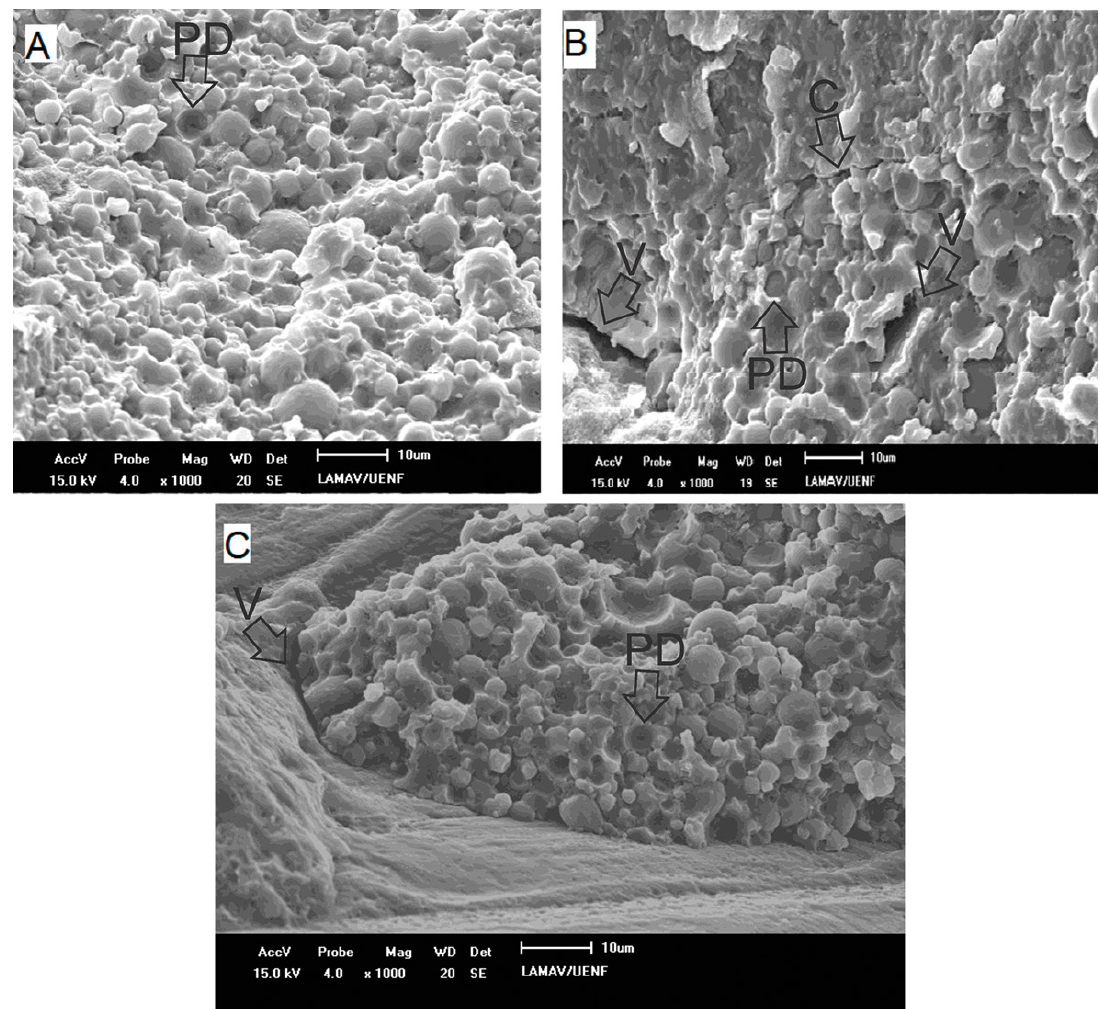
Figure 4: Sample surface micrographs with magnification of 1000x for formulations: A) P(3HB):ND(8:1), B) P(3HB):ND(12:1) and C) P(3HB):ND(16:1). The abbreviation C, V and PD, stands for: cracks, voids and particle debonding, respectively.